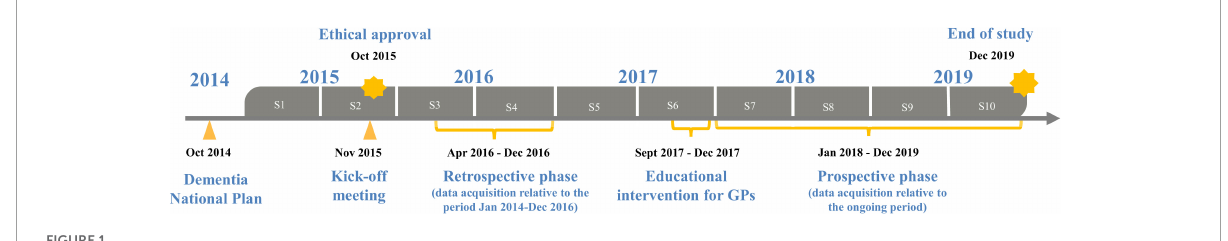
FIGURE1 NET-2011-02346784-WP5 study design, from 2015 to 2019, each year of study consisting of two semesters